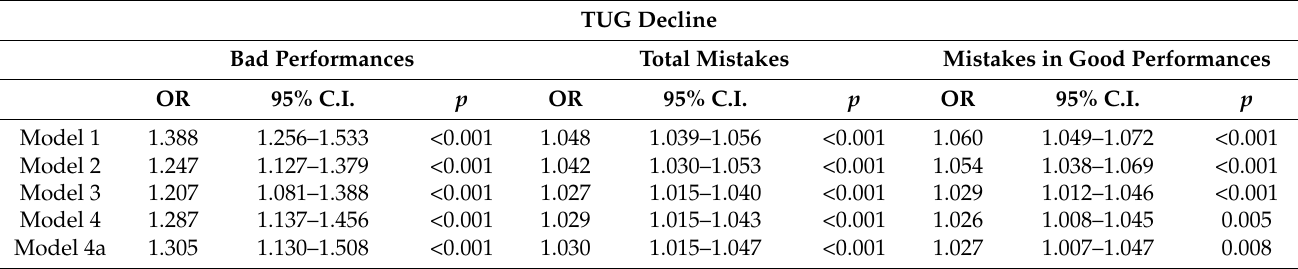
Table 2. Comparison of the OR and corresponding 95% C.I. of bad performances , total mistakes, and mistakes in good performances for the prediction of TUG decline in the binary logistic regression